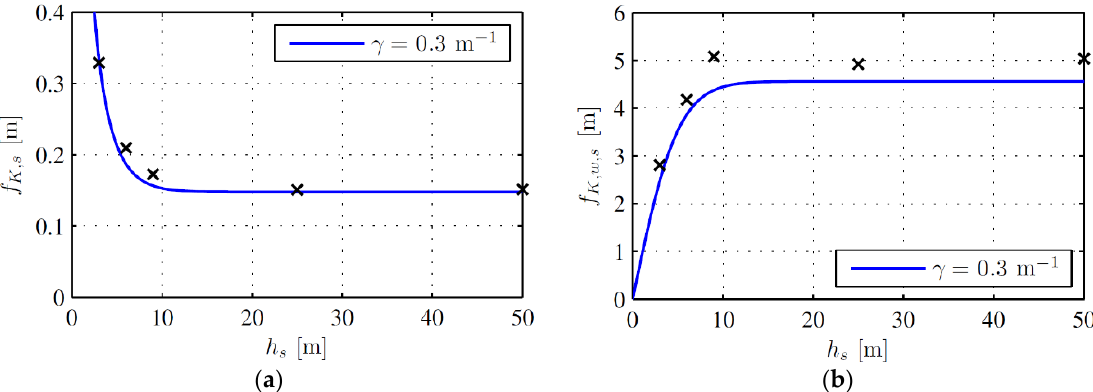
set. Vertical displacements for the representative load of 40kN are compared in Figure 13. Figure 12. Optimum values from Table 2 (crosses) and proposed expression (blue line) when h b = 0.3 m: ( a ) f K , s ; ( b ) f K , w , s .